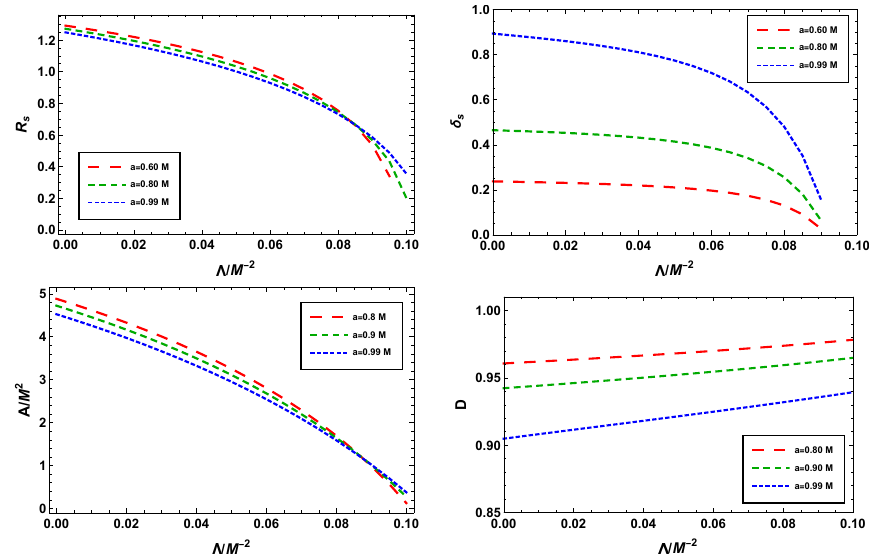
Figure 8. Variation of the shadow observables with Λ for different spins a for a static observer at ( r o , θ o ) = ( 4 M ,90 ◦ ) .